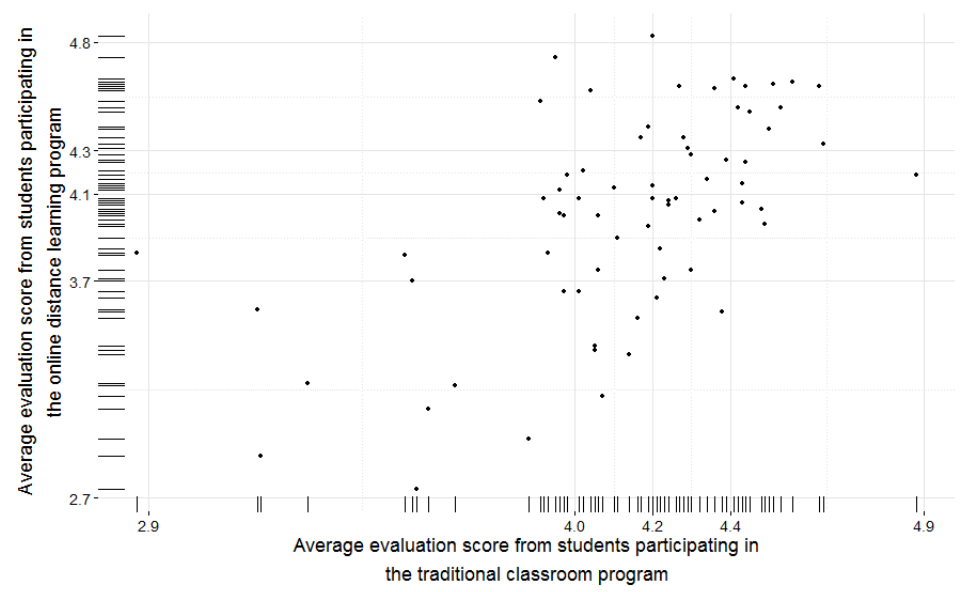
Figure 1. Scatter plot of mean evaluation scores received from students participating in the two programs with “rug” density plots on